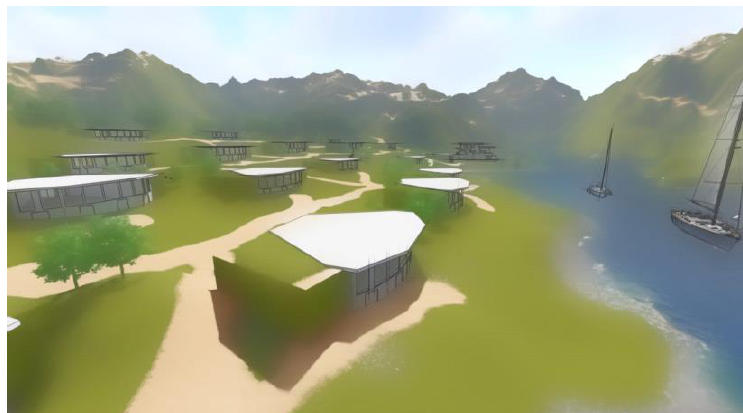
Figure 33. Perspective presentation with the hierarchy of horizontal levels on the slope of the tourist resort. As the Romans built their amphitheatres millennia after Lepenski Vir, so in this tourist settlement all units were built so that everyone has an unhindered view of the river. So not only units close to the river, but also all the others in the slope above, have a great view of the river. The units are placed on a slope alternately, as benches in amphitheatres; so that no one is disturbed in viewing the river as a scene. Lepenski Vir, Serbia (2019) by ArhiArhi (Predrag, Vladimir and Grigor